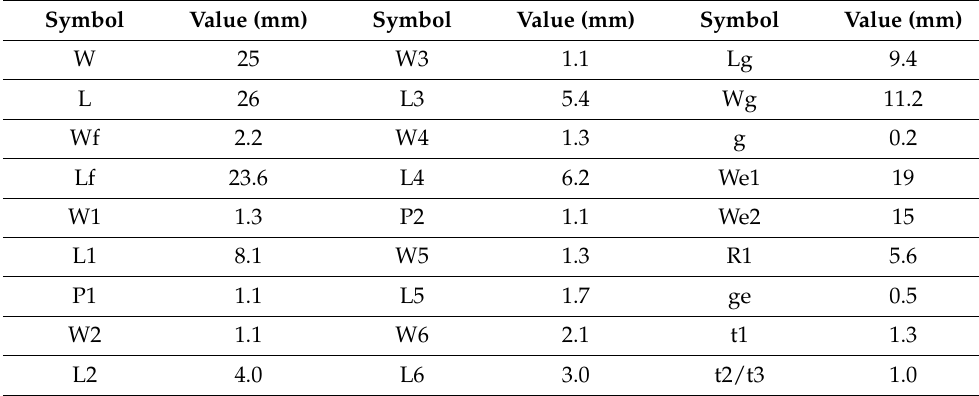
Figure 9. Configuration of the integrated antenna with the EBG array. ( a ) Simulation model. ( b ) Prototype photo. Table 2. Design parameters of the integrated antenna.